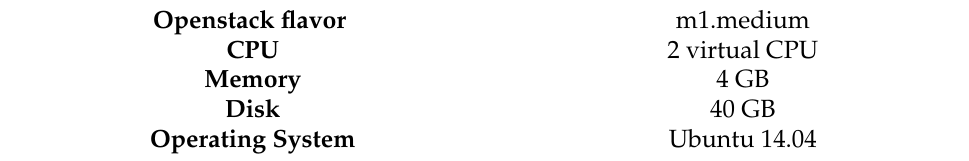
Table 4. Openstack instance specifications.